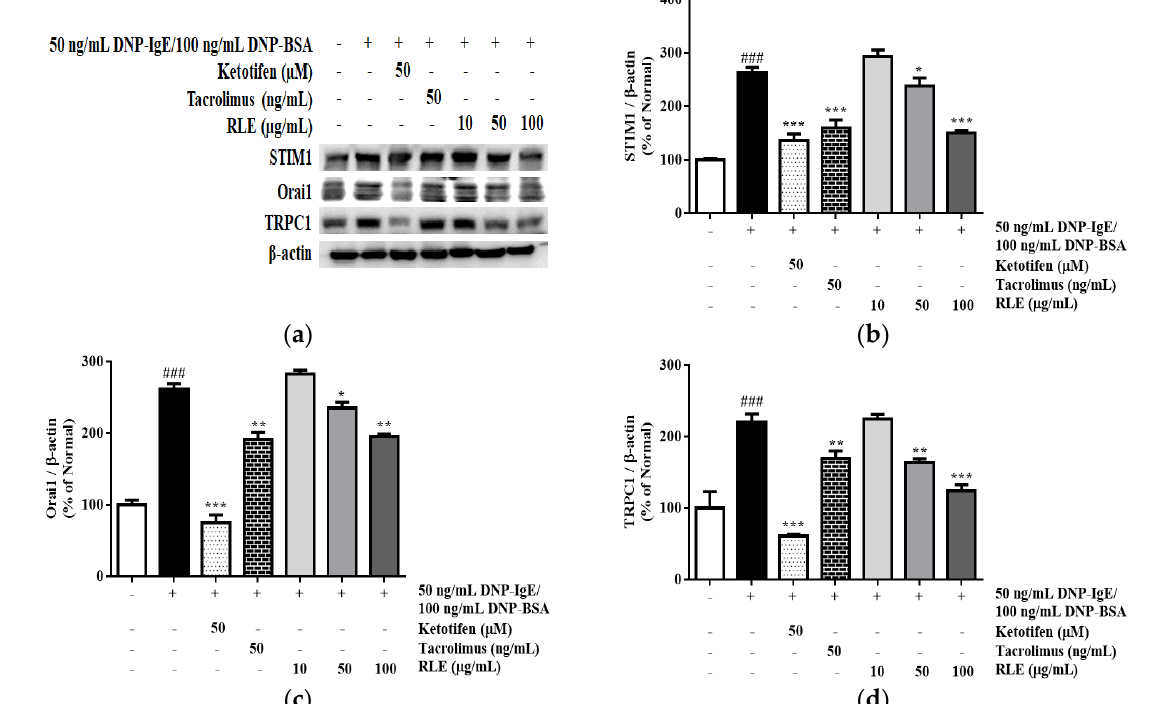
Figure 11. The effects of R. davurica Pall. leaf extract on the protein expression of STIM1, Orail1, and TRPC1. The protein levels were determined by western blot ( a ). The band intensities were quantified by densitometry, normalized to the level of STIM1 ( b ), Orail1 ( c ), and TRPC1 ( d ) calculated as the percentage of the non-treated group. Data are presented as the mean ± SD. * indicate significant differences between the non-treated cells and DNP-IgE/BSA-sensitized groups, respectively. ### p < 0.001 vs. the non-treated group. *, ** and *** p < 0.05, 0.01, and 0.001 vs. the DNP-IgE/BSA-sensitized control, respectively.